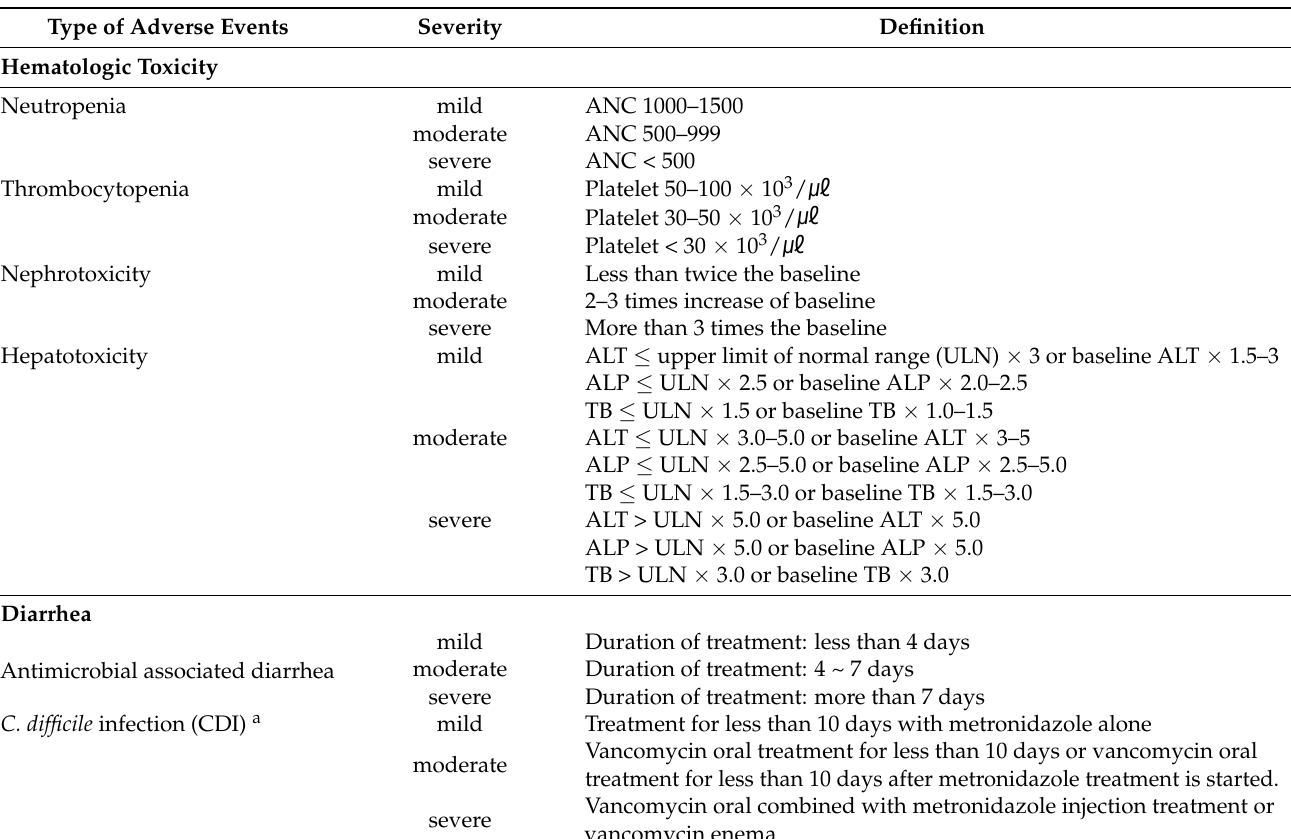
Table 5. Criteria for evaluating the severity of toxicity according to the type of adverse events.